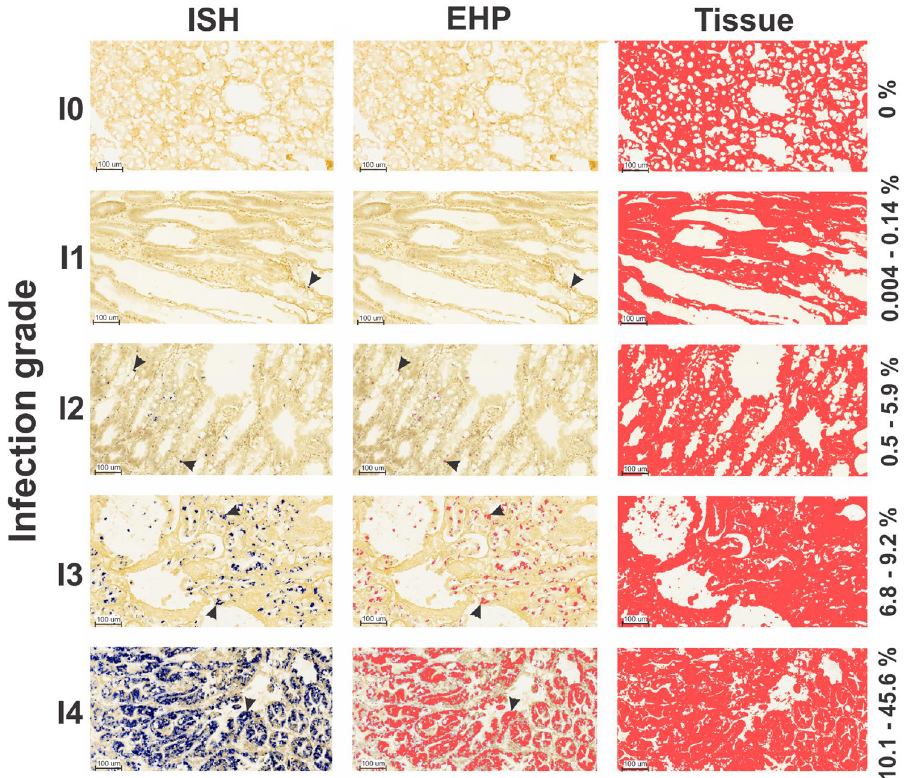
Figure 2. EHP infection intensity grade scale. Infection grade was assessed by in situ hybridization (ISH) using the EHP infection index (EII) and assigned by the methodology proposed by Lightner 21 . Each infection grade category (I0–I4) was represented for the first time by a value range of EII (%) shown at the right side of the image. The figure shows how the EHP and tissue area are separately quantified using ×10 image to calculate the EII according to each infection stage proposed by Lightner 21 . Black arrows mark EHP